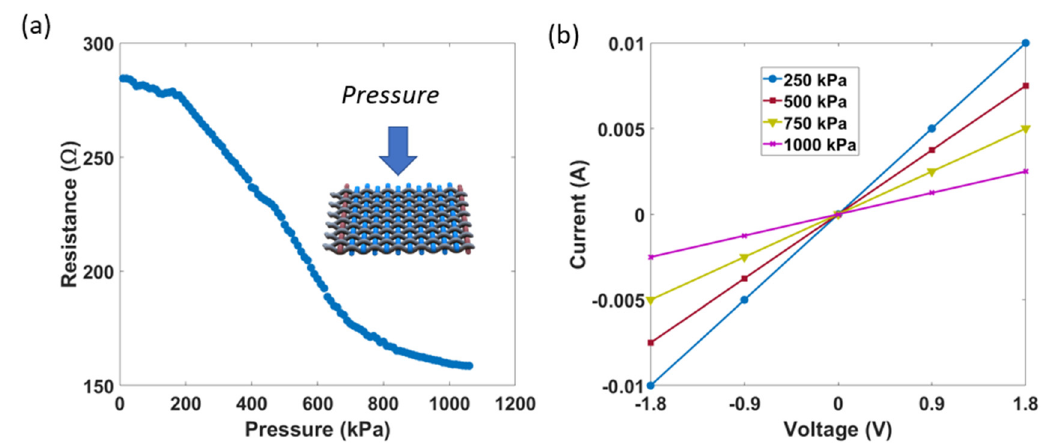
Figure 4. ( a ) Relationship of resistance and pressure, ( b ) I-V curves.